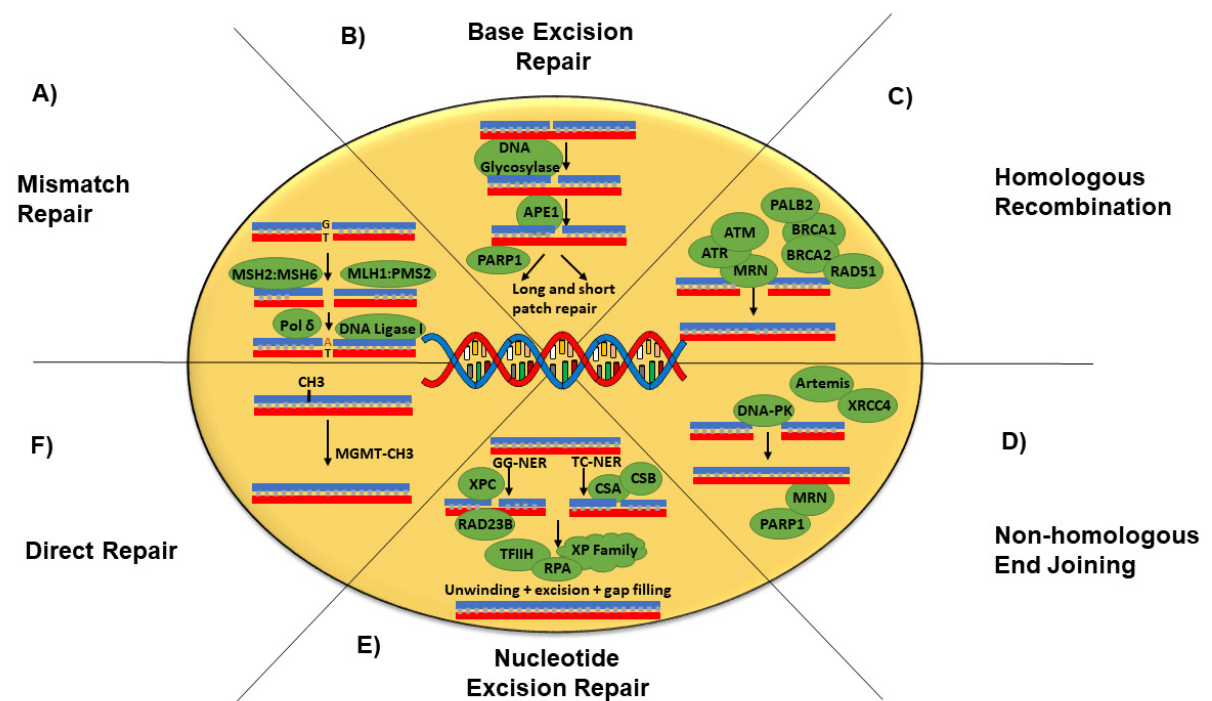
Figure 1. Summary of the six main mechanisms responsible for the DDR. ( A ) Mismatch repair: At the beginning of the process of the mismatch repair, mispaired bases are recognized by the sliding clamp MutS α homolog (MSH2:MSH6). Subsequently, the MLH1:PMS2complex is recruited for the incision, followed by the excision of the damage by exonuclease-1, resulting in a gap, which is then filled by Pol δ and DNA ligase I. ( B ) BER: This pathway is responsible for the removal of small co- valent modifications. These lesions are recognized by one of the specific DNA glycosylases and then hydrolyzed by AP-endonuclease (APE). PARP1 is recruited by nicked DNA due to APE1 and aid in DNA repair. If a single nucleotide is damaged, then the shortpatch BER pathway repairs it. The long-patch BER pathway is responsible for the repair of a lesion of at least two nucleotides. ( C ) Homologous recombination: This pathway is involved in the repair of the double-strand breaks and is carried out in late S and G2 phases when the homologous sister chromatid can be used as a tem- plate. In this process, ATM facilitates the activity of MRN complex at the site of DNA damage. The MRN complex then resects DNA from the dsDNA break site and the DNA strand is digested. As a result, single-stranded DNA is produced and RPA binds to it. BRCA1 and BRCA2 proteins (linked